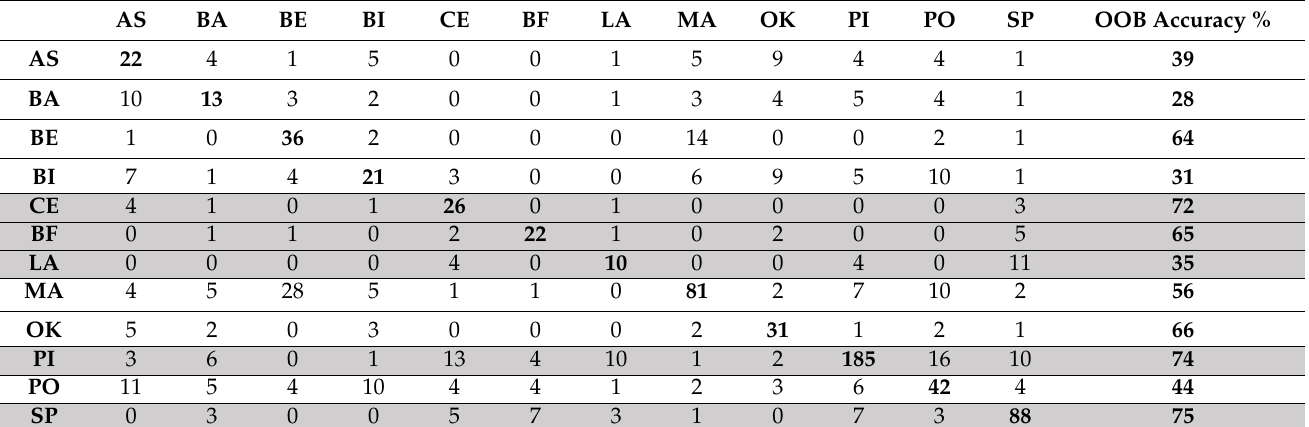
Table 7. Confusion matrix for 12 species classification using best model (all sensors, all